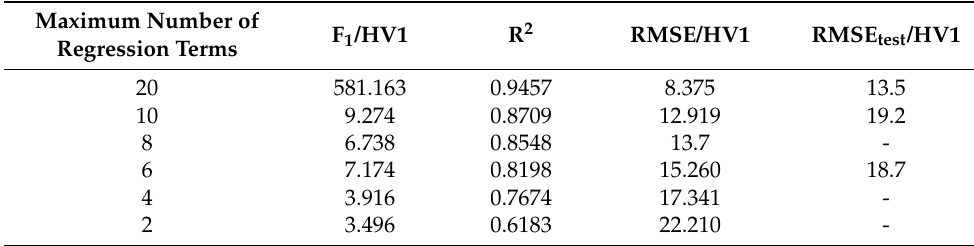
Table 7. Maximum error effect, coefficient of determination, and standard error in dependence of the maximum number of regression terms for regression analysis of hardness.